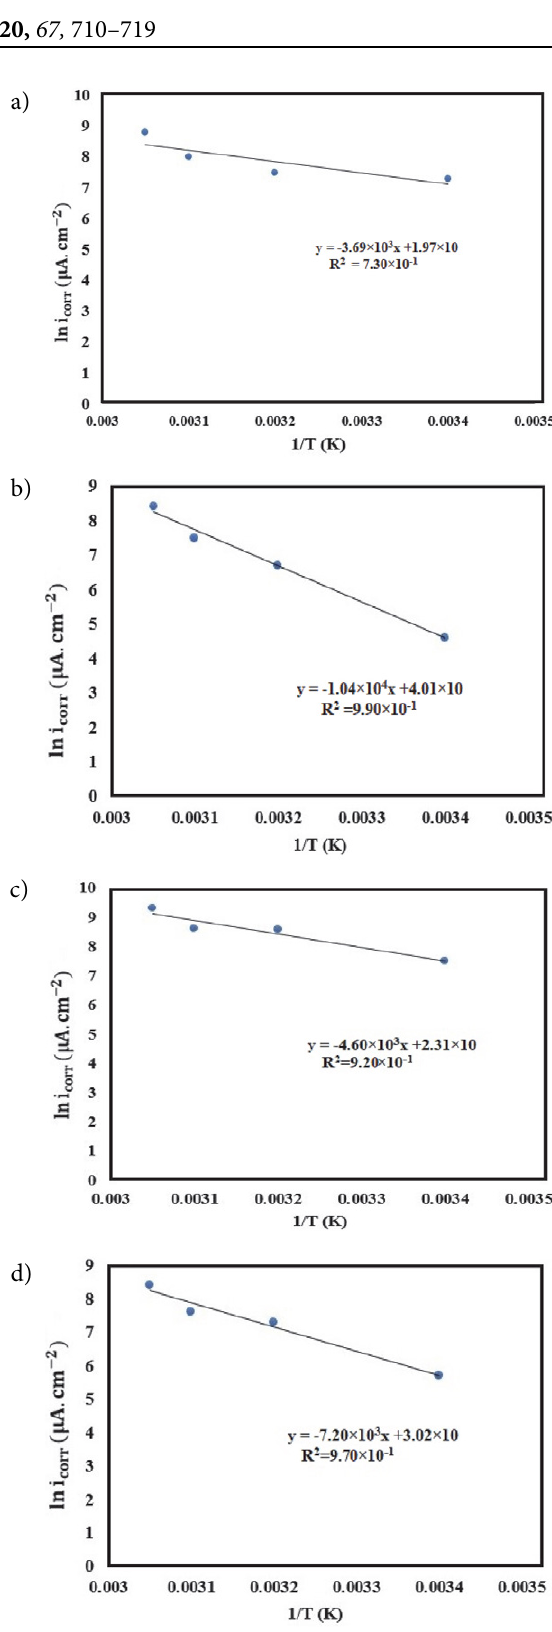
Figure 6. Arrhenius slopes calculated from corrosion current den- sity for mild steel in 1 M hydrochloric acid, a) without inhibitor, b) with inhibitor and 0.5 M sulforic acid solution c) without inhibitor d) with